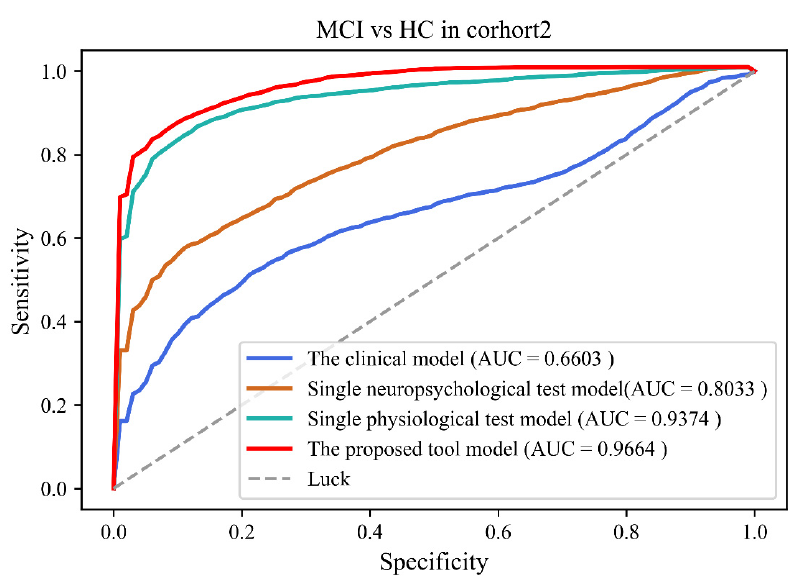
Figure 3. The receiver operating curves of four models in cohort 2.